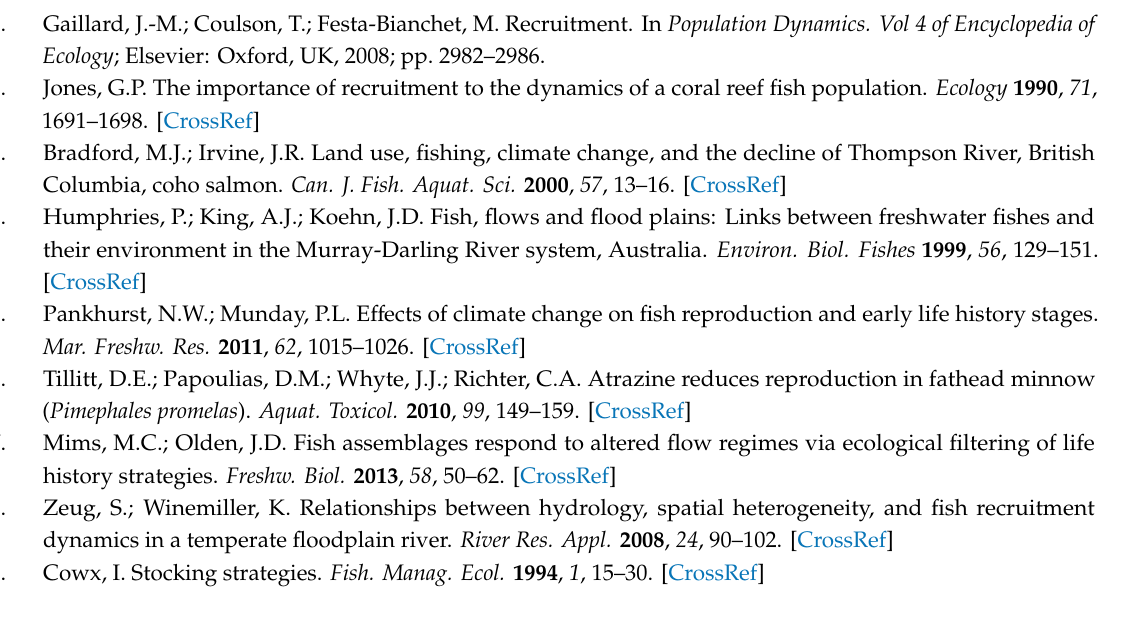
Figure S1: A schematic diagram of otolith processing. The best section containing core of the otolith was selected to mount on glass slide. 1 and 3: 200–300 µ m sections from each side of the core. 2: the otolith section with the core; Table S1: Trace element compositions (ug · g − 1 ) in core and edge of Lachlan River samples and core of the hatchery YOY samples. H = Hatchery, LL = Lower Lachlan and UL = Upper